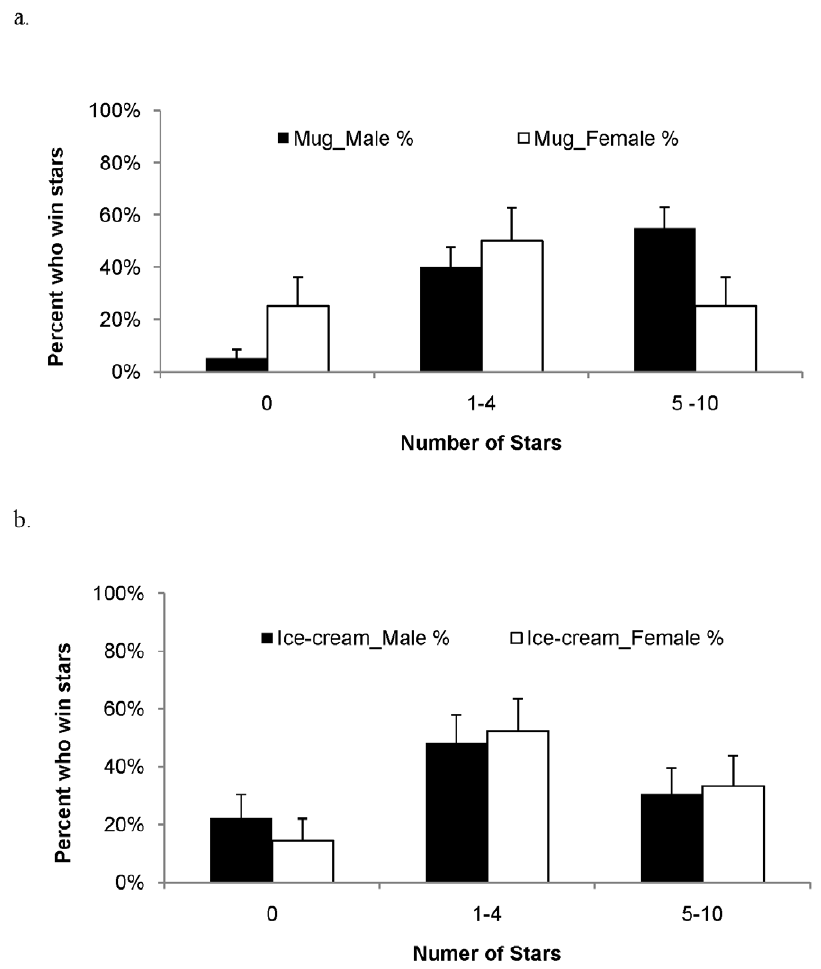
Figure 3. Number of stars won in Mug and Ice-cream treatments. Each panel describes the percent of males and females who won different numbers of stars (tying allowed) in Mug or Ice-cream . a. Percent of males (filled bars, N=40) and females (open bars, N=16) winning 0, 1–4 or 5–10 stars in Mug . Significantly more males than females won at least one star, or at least five stars over 10 periods. b. Percent of males (filled bars, N=27) and females (open bars, N=21) winning 0, 1–4, or 5–10 stars in Ice-cream .